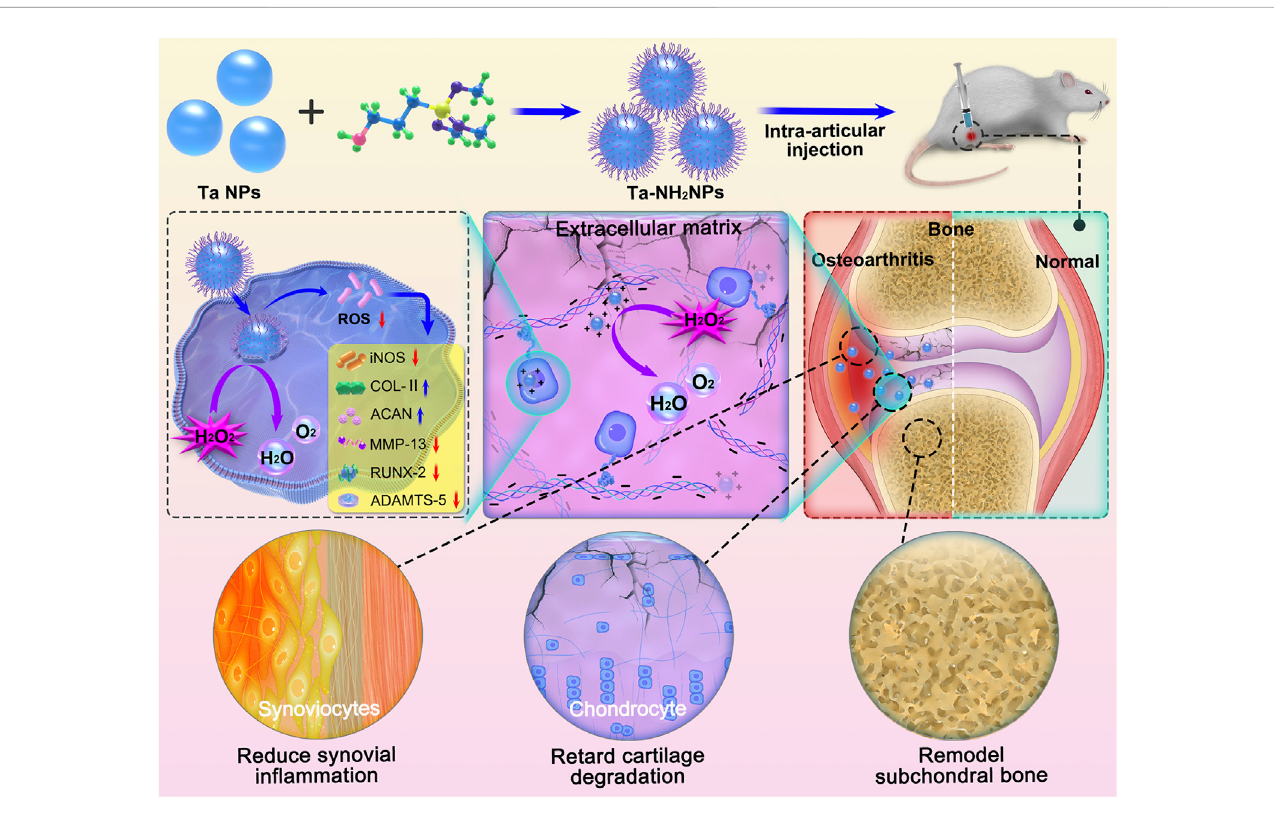
FIGURE 1 Schematic diagram of the synthesis of Ta-NH 2 NPs and the treatment of OA with single intra-articular injection. Positively charged NPs obtained by adding amino groups to the surface of Ta was injected into the osteoarthritic joint cavity. Ta-NH 2 NPs exhibit long-term oxidative stress attenuating effect in articular cartilage, and alleviates OA